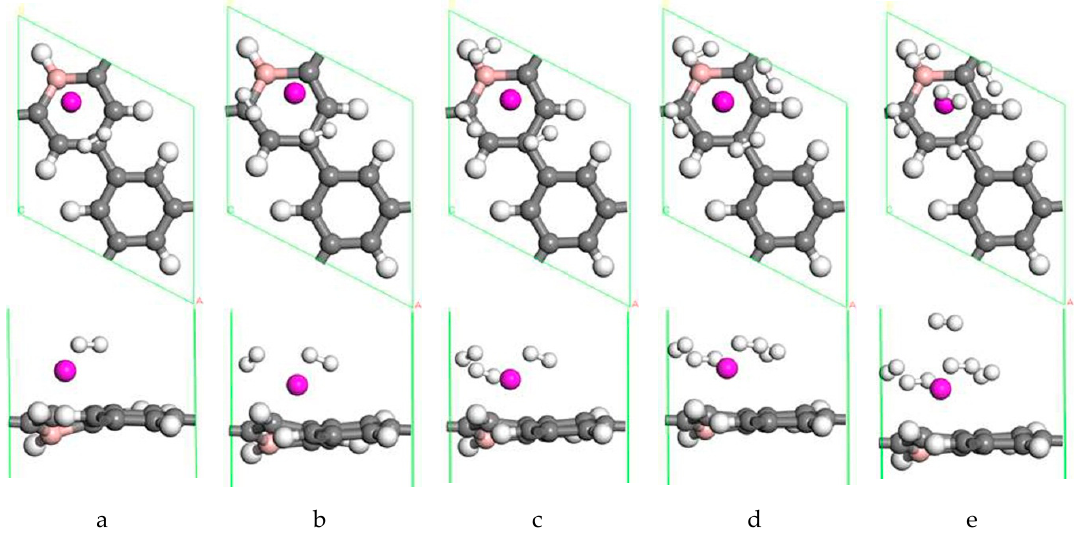
Figure 4. The optimized geometries of a single Sc-modified B-PG system with one H 2 molecule ( a ), two H 2 molecules ( b ), three H 2 molecules ( c ), four H 2 molecules ( d ) and five H 2 molecules ( e ) adsorbed. Table 2. Calculated adsorption energy and average adsorption energy of H 2 , distance between Sc atom and H 2 molecules, and minimum distance between Sc atom and C atom in Sc-modified B-PG system.